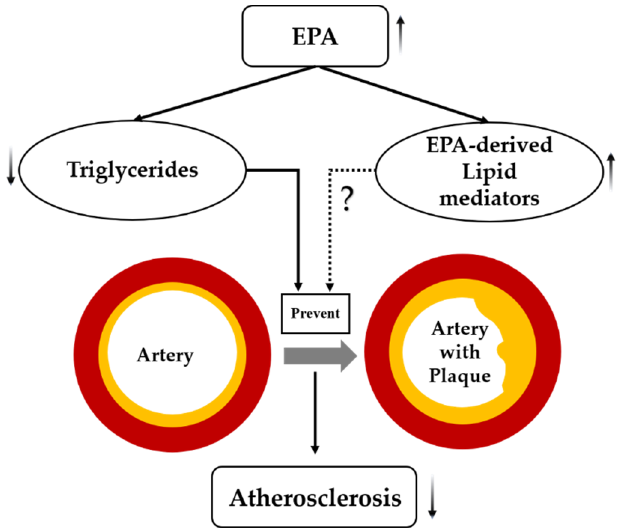
Figure 5. Postulated mechanism(s) by which EPA suppresses atherosclerosis. Dashed lines indicate possible effects of EPA that need further investigation, solid lines indicate effects of EPA that are well established in the scientific literature, arrows indicate increased or decreased.